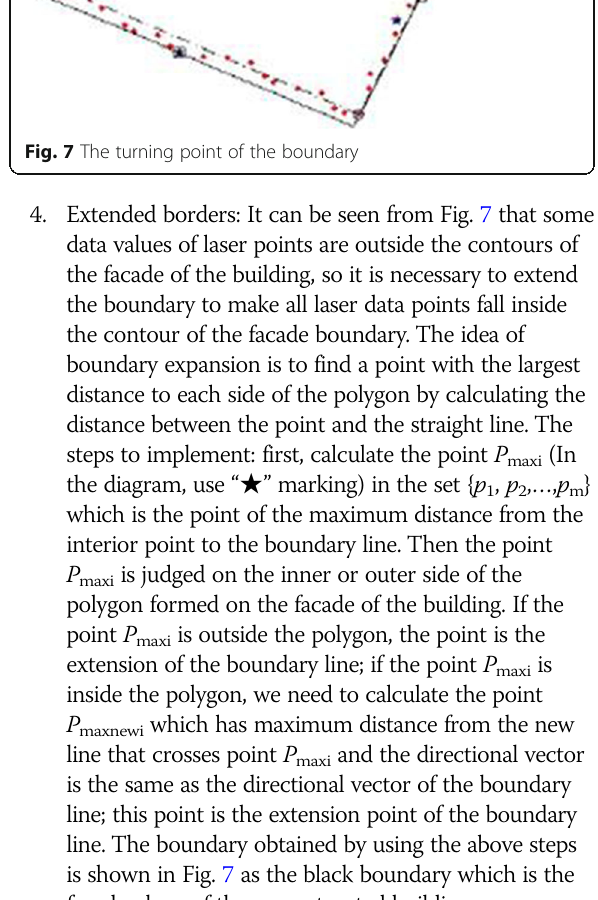
Fig. 5 Initial boundary line and boundary point of elevation